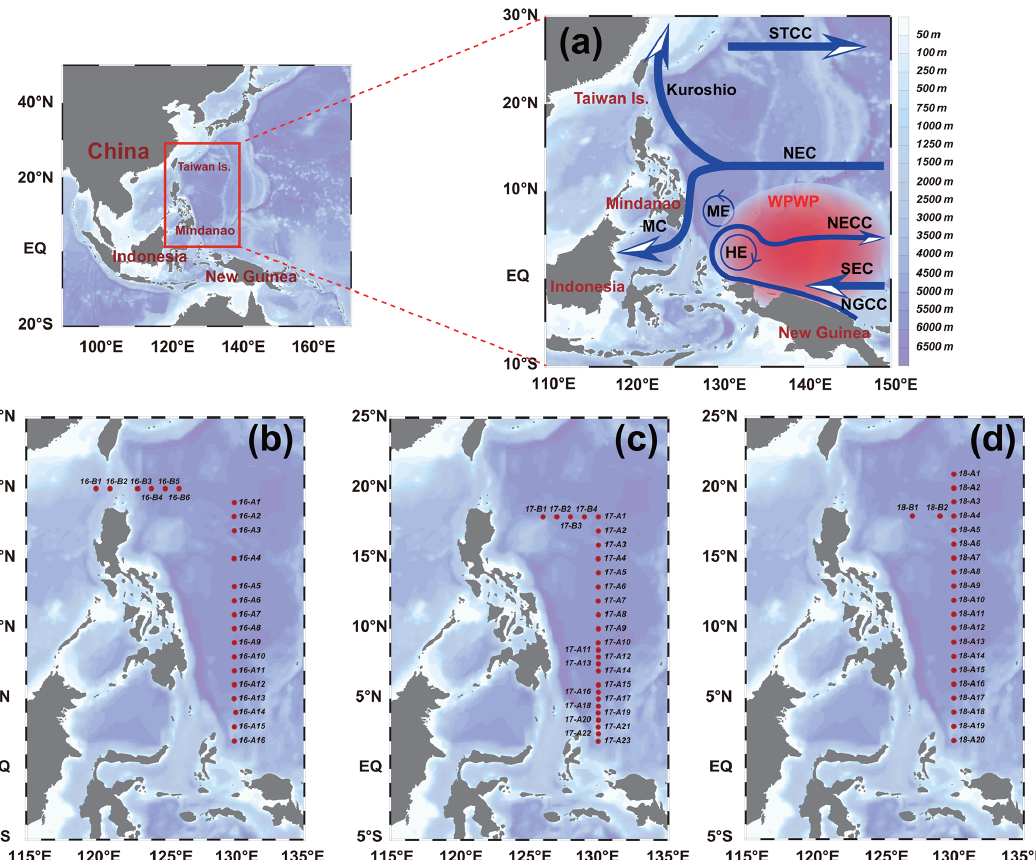
Figure 1. Stations in the western Pacific Ocean (WPO) of three cruises. (a) Current systems of the WPO; (b, c, d) sampling stations of the 2016, 2017, and 2018 cruises, respectively. The station at 130 ◦ E forms section A, and the station at 20 ◦ N forms section B. Map of the WPO shows the major geographic names and the surface currents, including the Subtropical Counter Current (STCC), the North Equatorial Current (NEC), the North Equatorial Counter Current (NECC), the South Equatorial Current (SEC), the New Guinea Coastal Current (NGCC), the Mindanao Current (MC), the Mindanao Eddy (ME), and the Halmahera Eddy